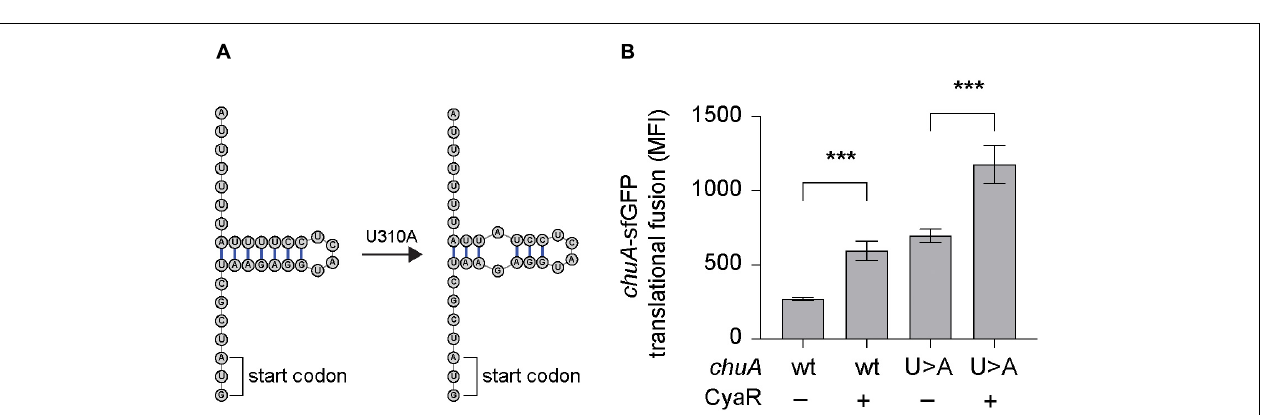
FIGURE 2 | CyaR activates chuA translation through direct base-pairing. (A) IntaRNA prediction of the chuA –CyaR interaction. Compensatory point mutations predicted to disrupt the interaction are indicated by the arrows. (B) Fluorescence measurements of wild-type or mutant chuA- sfGFP translational fusions in the presence and absence of wild-type or mutant CyaR overexpression plasmid. Measurements are the mean median fluorescence intensity of three biological replicates (** p < 0.01, * p < 0.05).